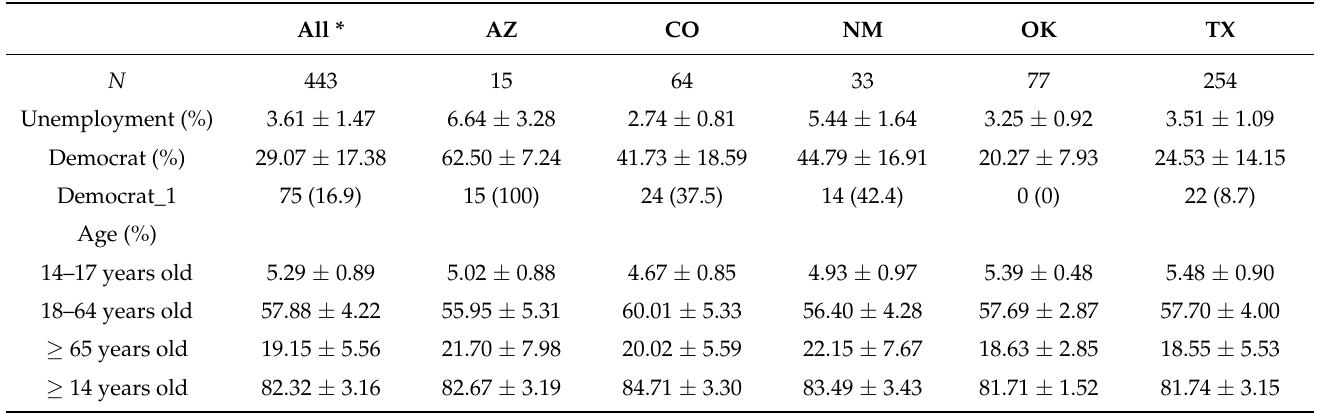
Table 2. Preliminary summary (mean ± sd/frequency (%)) of counties ( N = 443) and the information by